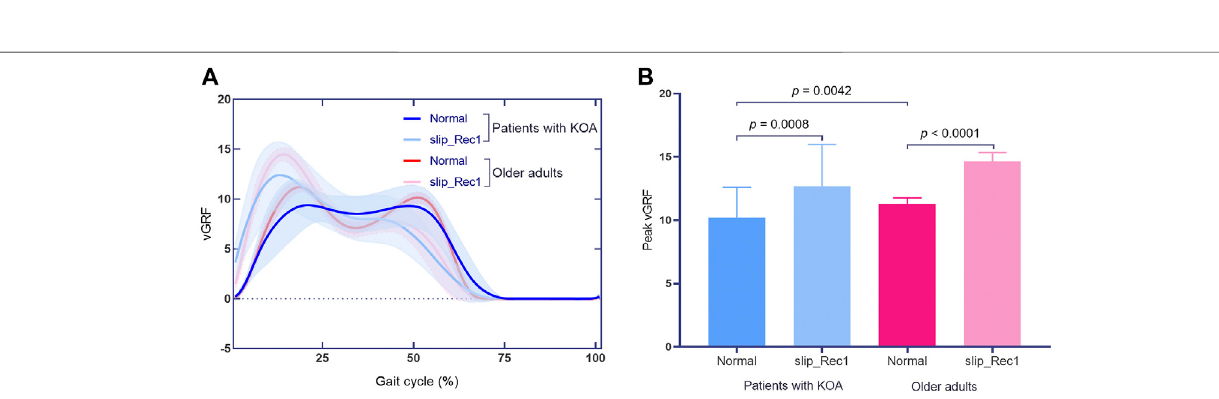
Frontiers in Bioengineering and Biotechnology |